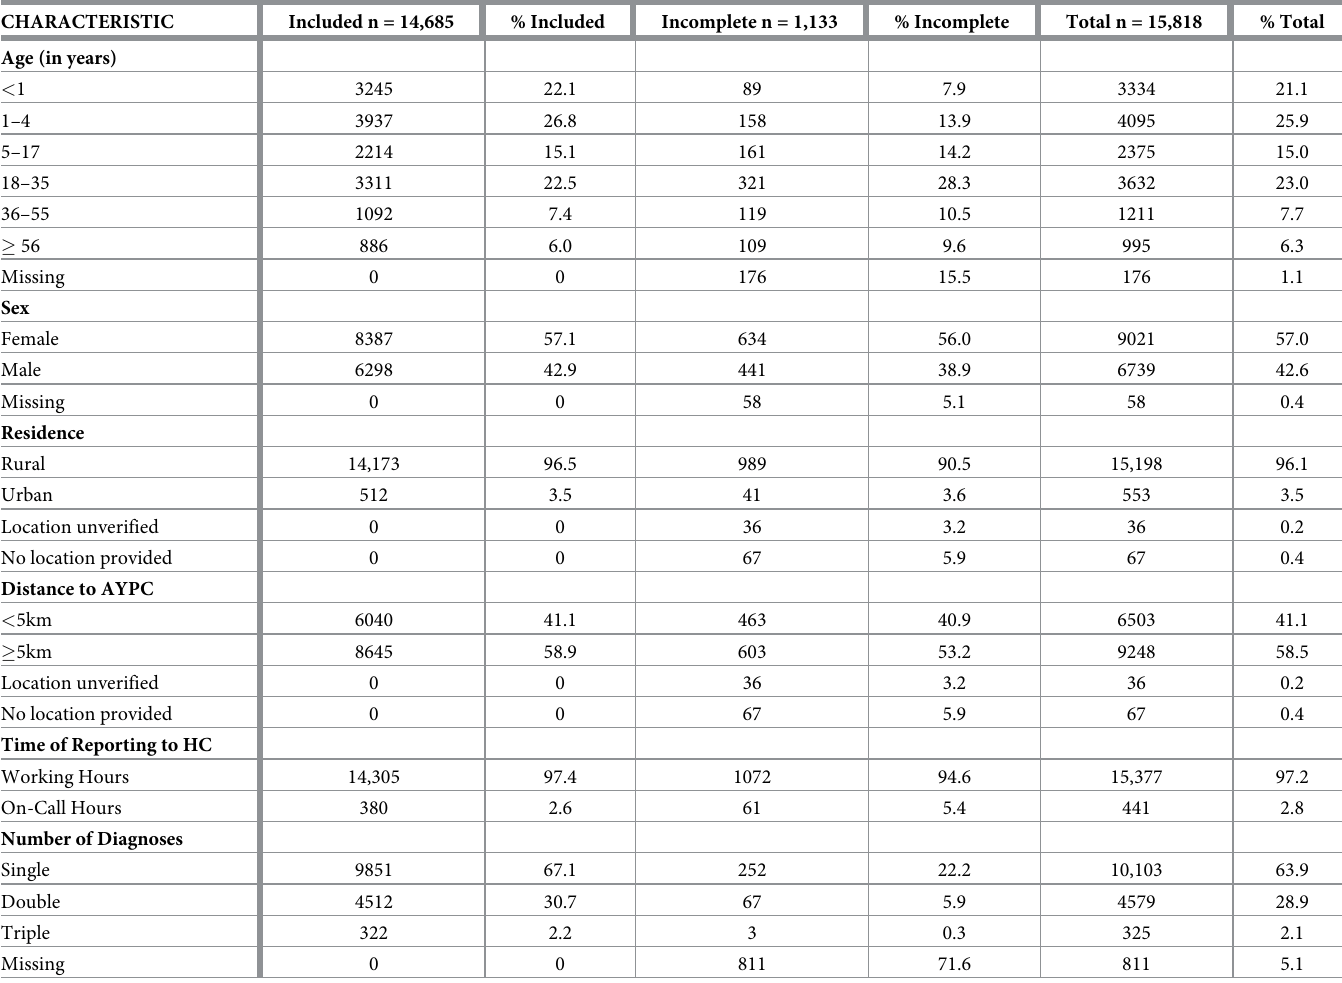
Table 1. Characteristics of clients and missingness at AYPC in Nakaale in